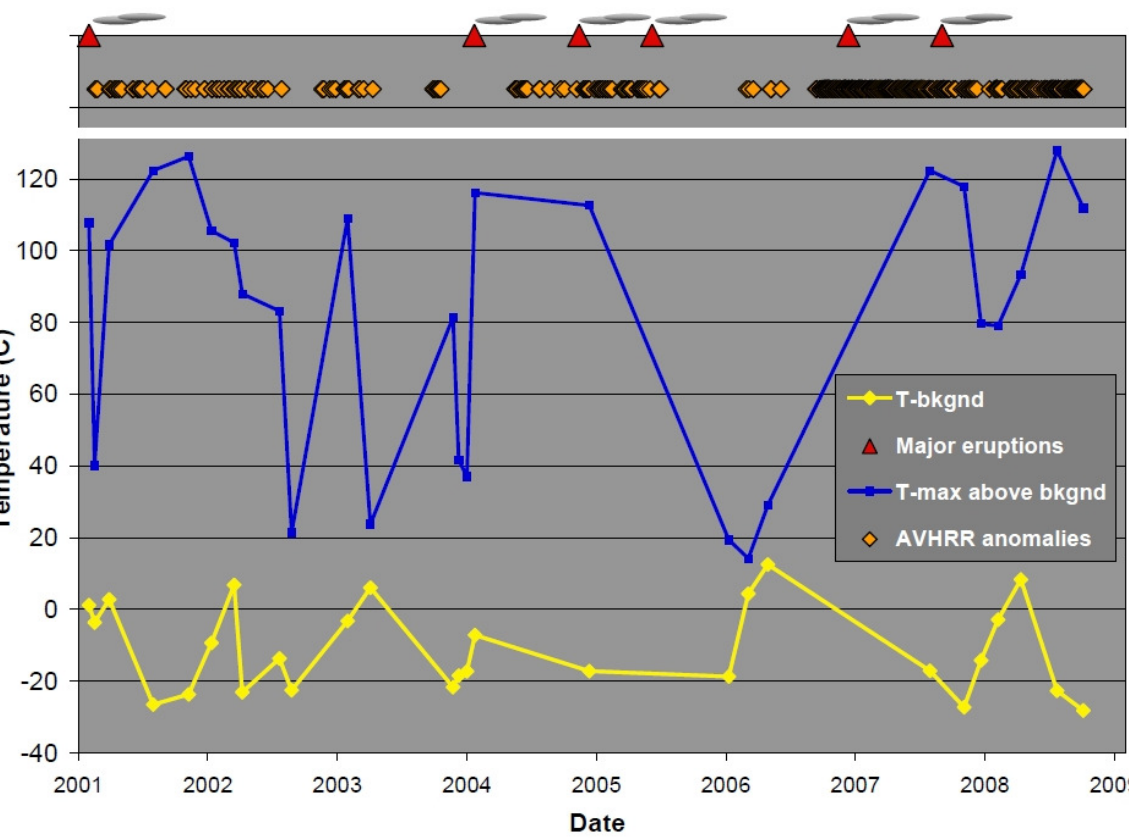
Figure 4. Multi-temporal thermal trends at Shiveluch from 1 January 2000 to 19 January 2009. ASTER-derived maximum pixel-integrated brightness-temperature (blue line) above the average background temperature (yellow line). Data were extracted from the hottest part of the lava dome. AVHRR thermal anomalies (orange diamonds) are shown at the top of the graph along with and the six major explosive eruptions as red triangles (19 May 2001, 9 May 2004, 28 February 2005, 22 September 2005, 29 March 2007, and 18 December